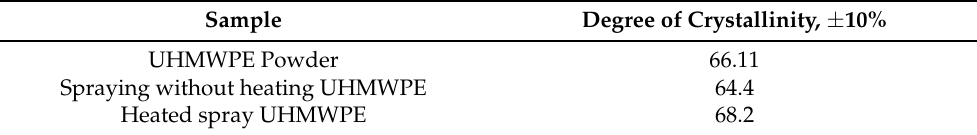
Table 5. The degrees of crystallinity of the initial powder and UHMWPE coatings.